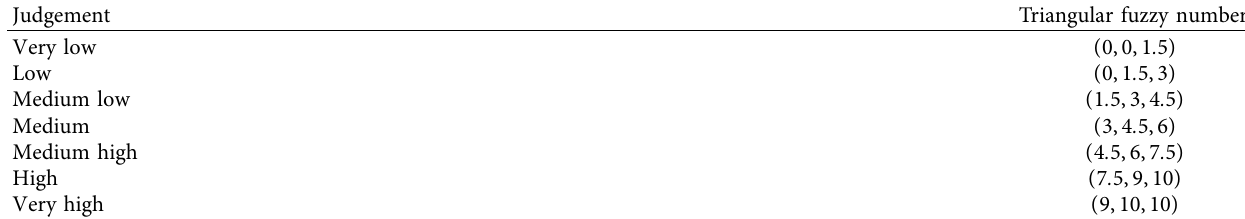
Table 4: Linguistic judgments and corresponding fuzzy numbers.